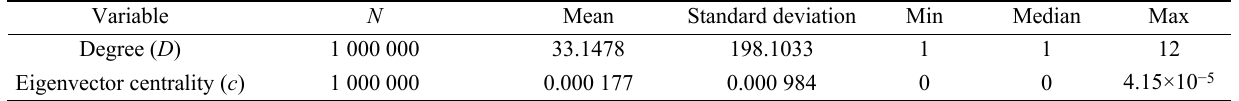
Table 3 Descriptive statistics of investors’ social network characteristics.